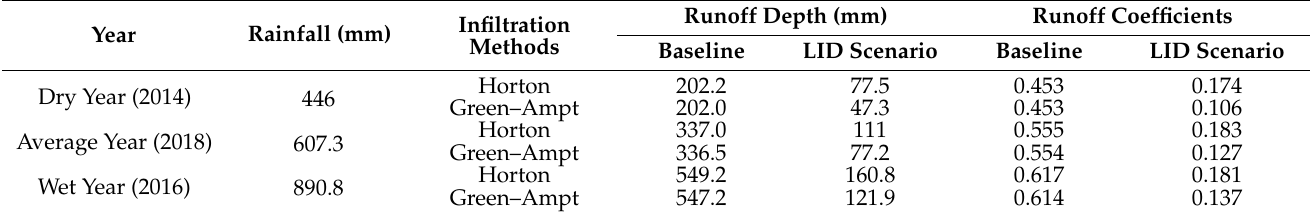
Table 8. Comparisons of the runoff control rates among the water years.